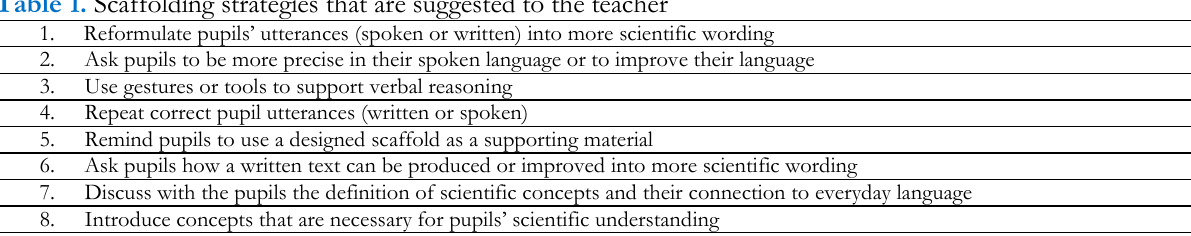
Table 1. Scaffolding strategies that are suggested to the